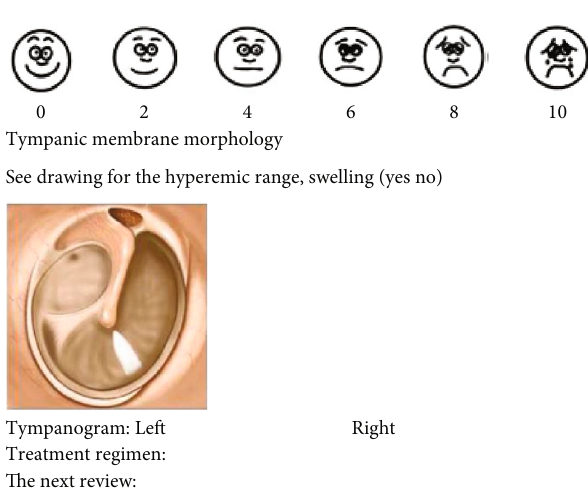
Figure 2: Clinical follow-up table of acute otitis